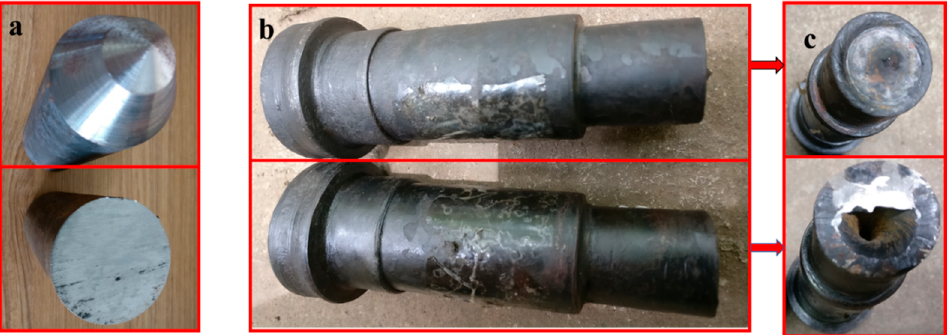
Figure 16. Billets and rolled products: ( a ) comparison of billets; ( b ) lateral comparison of rolled products; ( c ) axial comparison of rolled products.